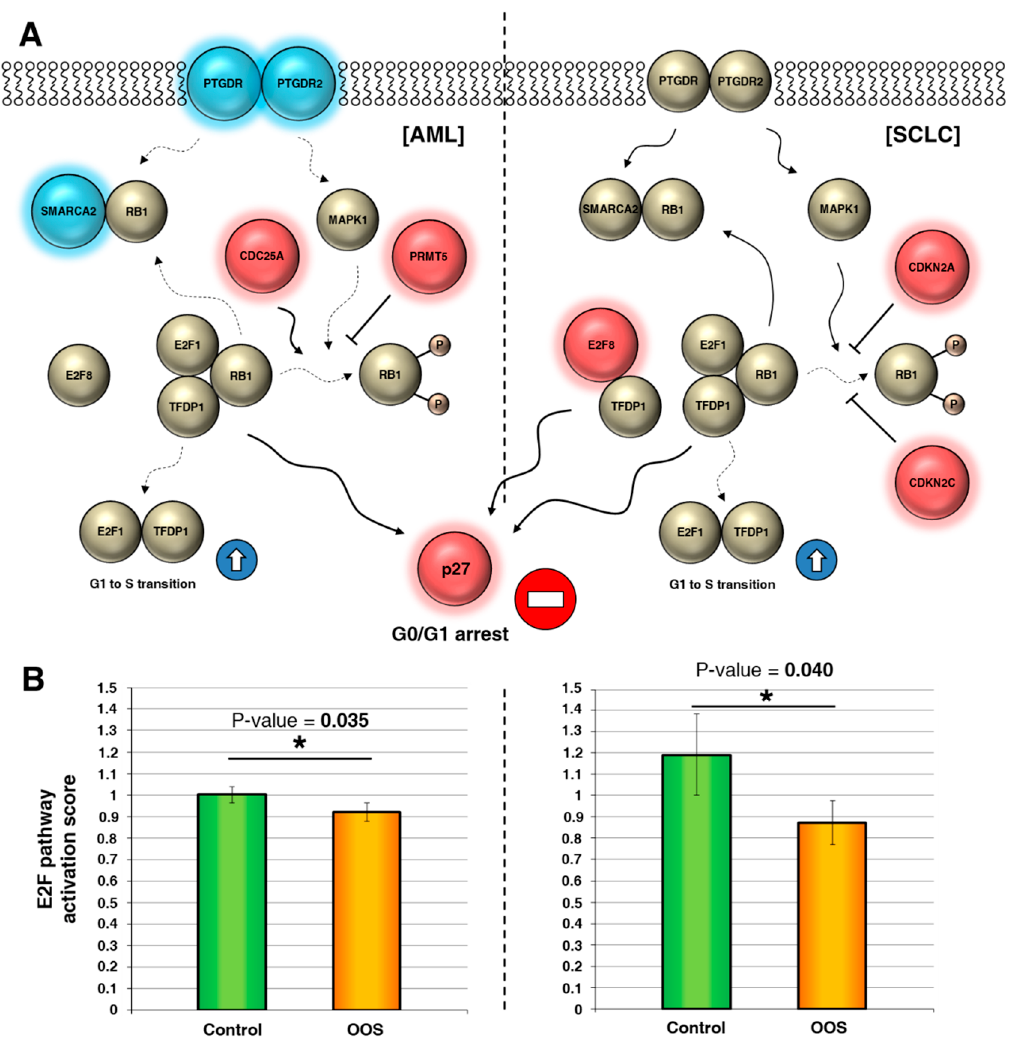
Figure 4. OOS downregulates the E2F pathway. ( A ) Interactions among E2F pathway genes deregulated by OOS in AML (left) or SCLC (right), represented in a flow chart network. Overexpressed genes after OOS treatment are displayed in shades of pink-red, and downregulated genes in shades of blue. ( B ) OOS contributes significantly to block the activation of the E2F1–TFDP1 pathway mediated by its regulators in both tumor models. E2F pathway activation scores were estimated as described in the Material and Methods section. * indicate statistically significant differences.